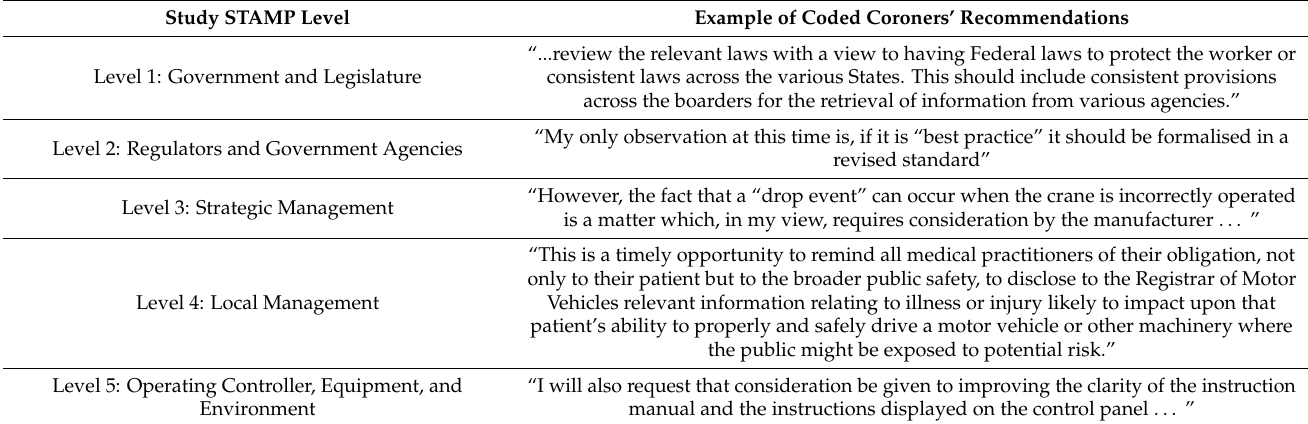
Table 2. Examples of Coroners’ Recommendations Coded at each STAMP